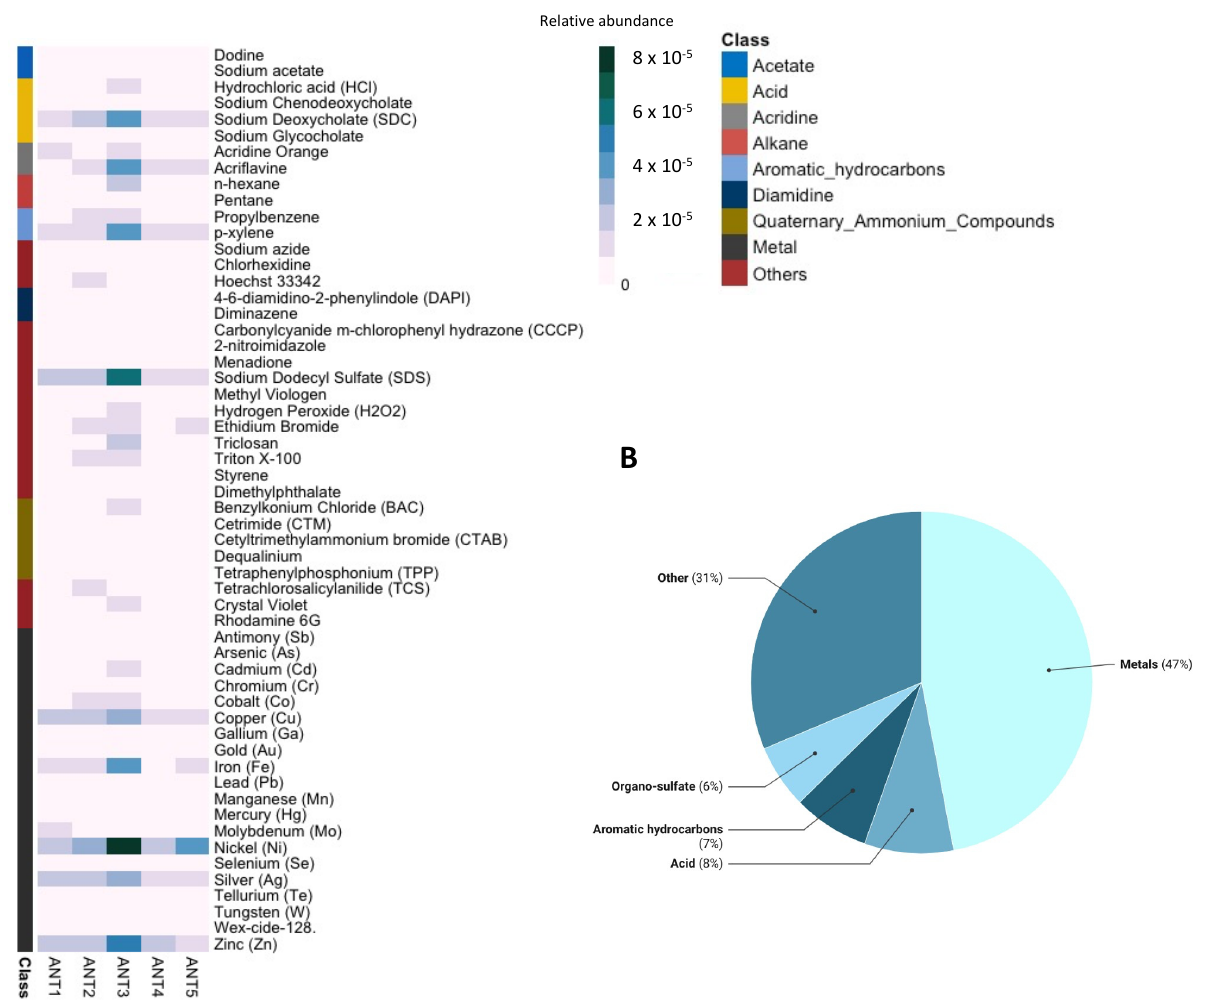
Figure 3. Relative abundance of ERG types in Deception Island ( A ) and their associated resistance class ( B ). Relative abundance in ( A ) was calculated by dividing the number of ERGs by the total ORFs number per sample. Percentages in ( B ) were calculated as the proportion of each ERGs class in the total number of detected ERGs.